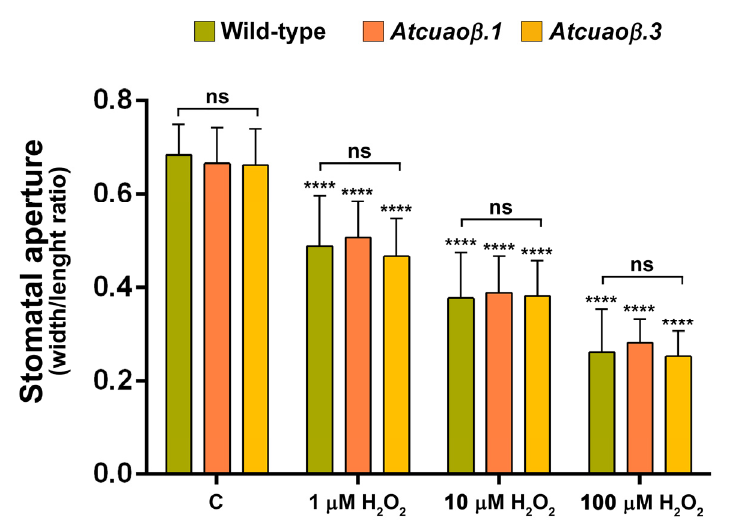
Figure 5. Effect of three different concentrations of H 2 O 2 on stomatal pore width/length ratio of seven-day-old WT, Atcuao β .1 and Atcuao β .3 mutant seedlings. Seedlings were treated for 1 h with 1, 10, or 100 µ M H 2 O 2 . Mean values ± SD ( n = 15) are reported. The significance levels between the treated plants and the corresponding untreated plants are reported for each treatment, while the significance levels between the WT and Atcuao β mutants supplied with the same concentration of H 2 O 2 (horizontal square brackets) are reported. p levels have been calculated with one-way ANOVA analysis; p levels > 0.05; ****, p ≤ 0.0001; ns: non-significant.